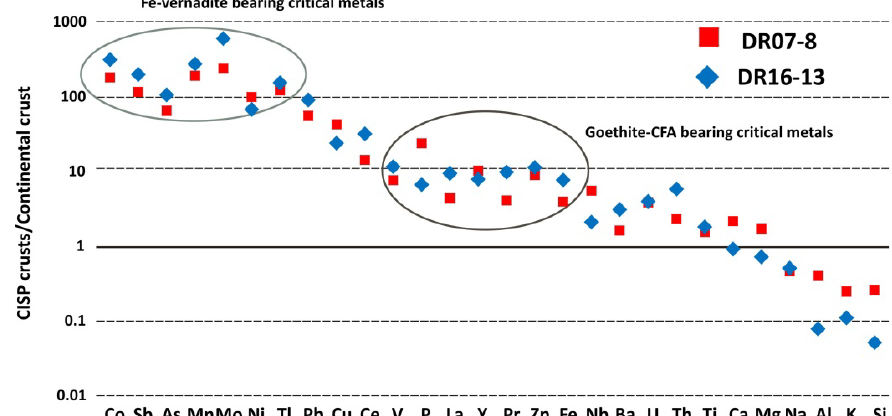
Figure 8. Element enrichment diagram for the composition of both studied crusts relative to the composition of the mean continental crust [67]; Mn-oxide (Fe-vernadite) bearing elements (Co, Ni, Mo and Tl) have been evidenced, in contrast with the Fe-oxyhydroxides and CFA bearing elements, (P, Y, V and Zn). Both crusts are depleted in aluminum-silicate elements.